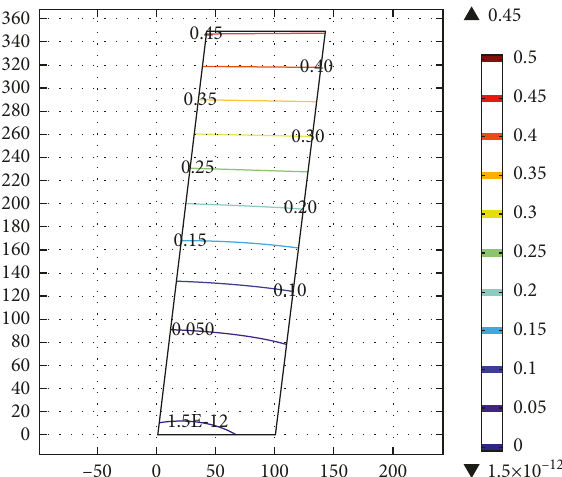
Figure 10: Horizontal displacement of the rock column at a mining depth of 350m.